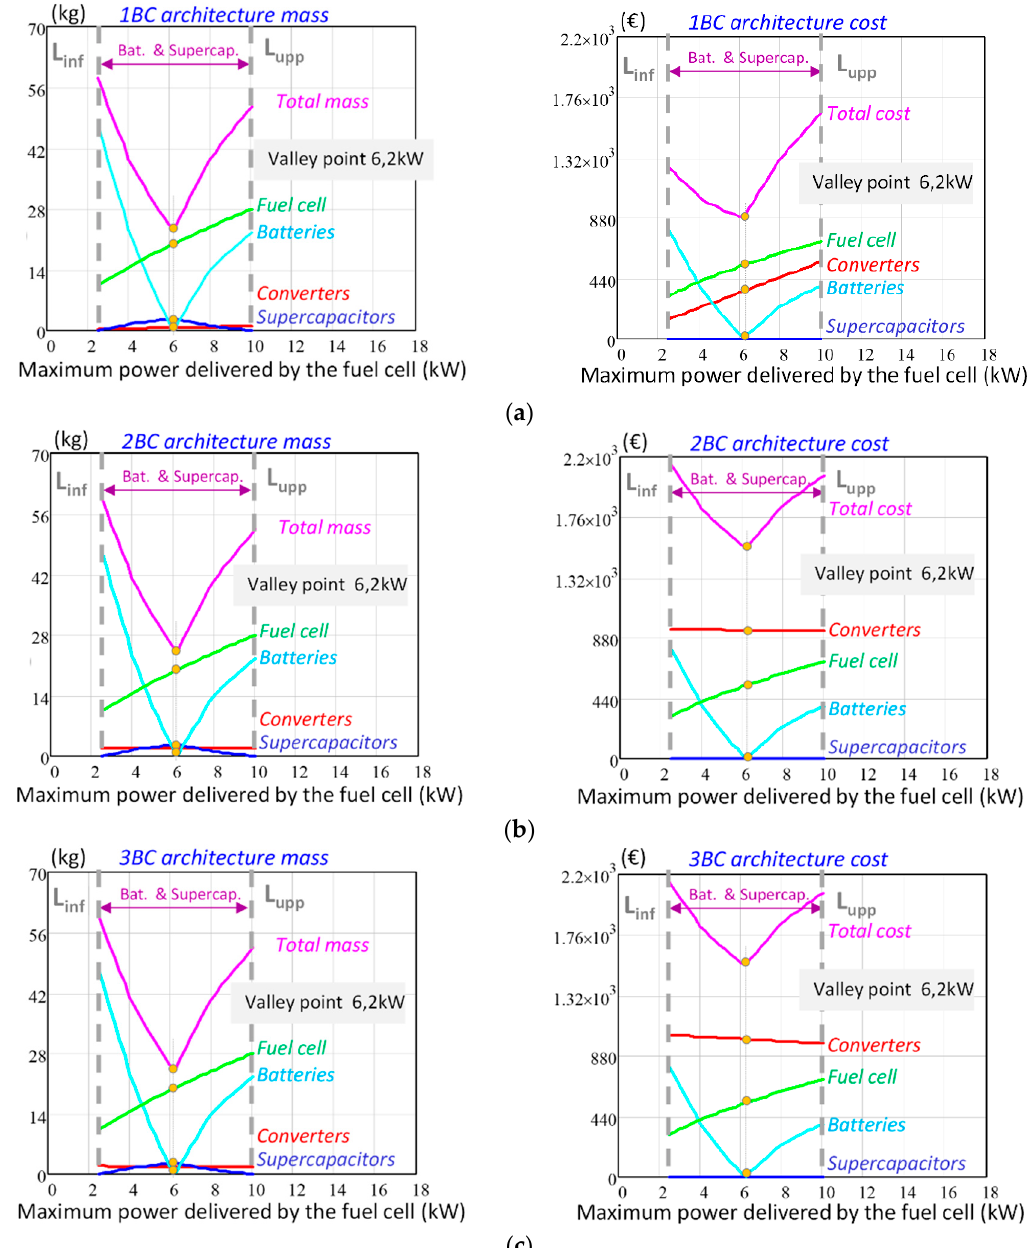
Figure 13. Total mass and total cost of PDS for the ECE-15 profile. ( a ) 1BC. ( b ) 2BC. ( c ) 3BC.